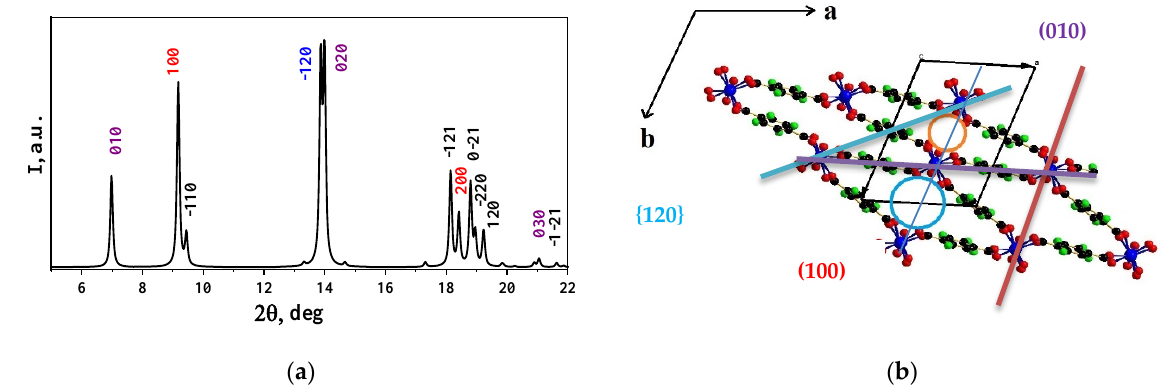
diffraction patterns MIL-53 (Fe) ( a ) and MIL-53 (Ga) ( b ), structure projected onto the ( c ) XY plane.